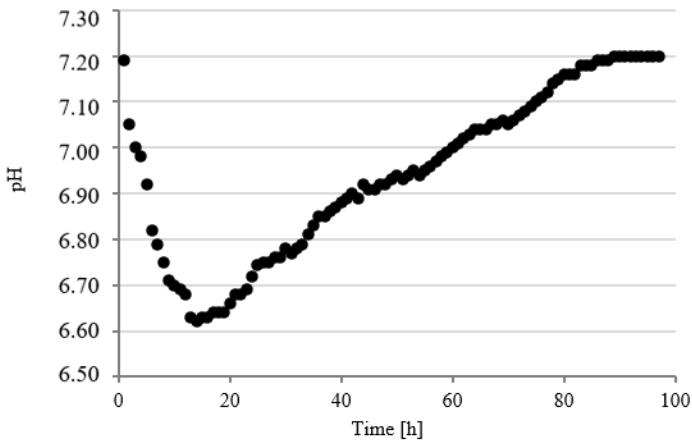
Figure 8. Course of pH changes in series 1.